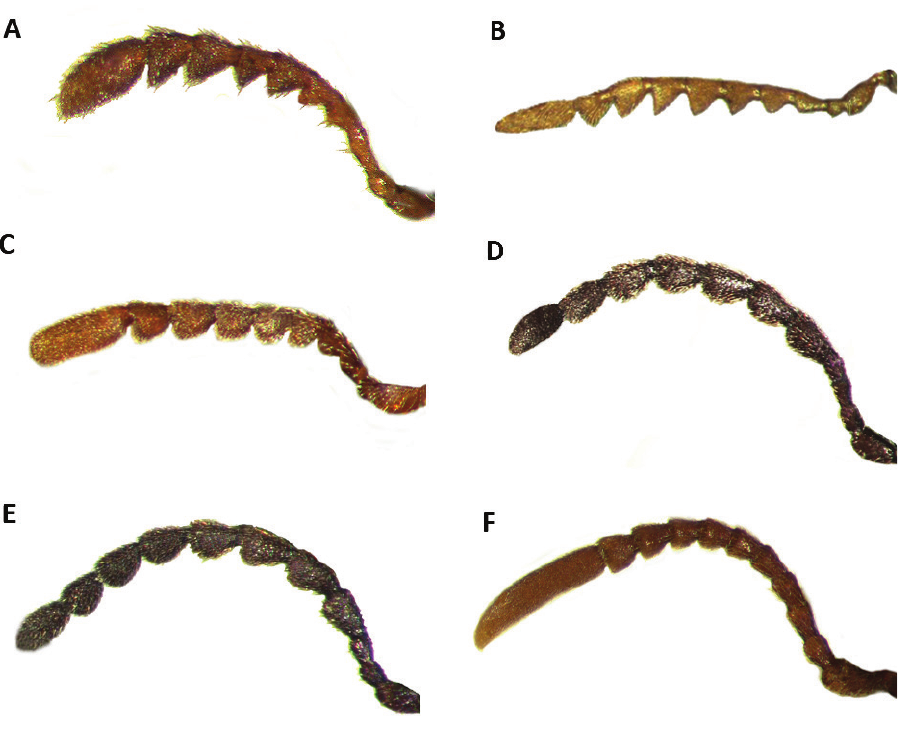
Figure 9. Antennae of: A Neocallotillus elegans ( vafer ) (female) B Callotillus eburneocinctus (male) C Cal- lotillus eburneocinctus (female) D Cymatoderella collaris (male) E Cymatoderella morula (male) F Lecontella brunnea (male)